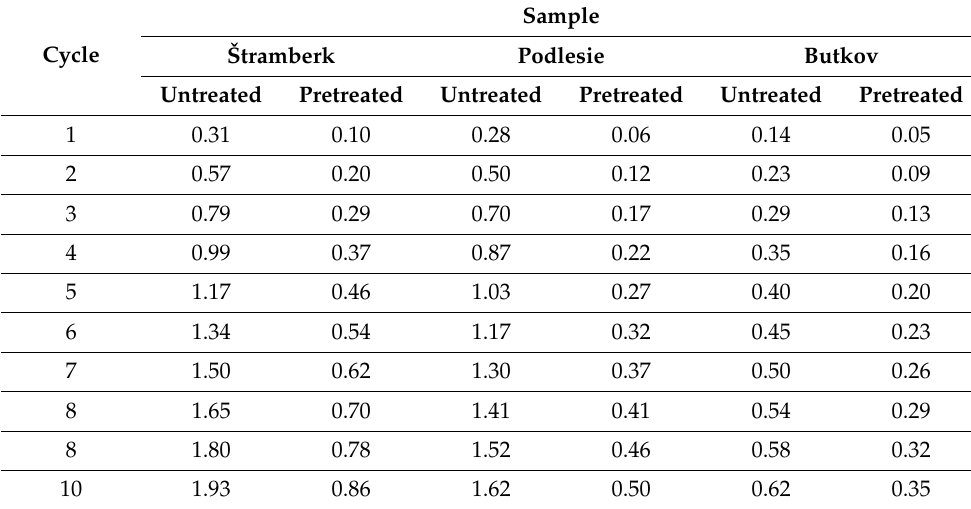
Table 3. Cumulative carbonation relative to the initial weight of the sorbent for raw and pre- treated